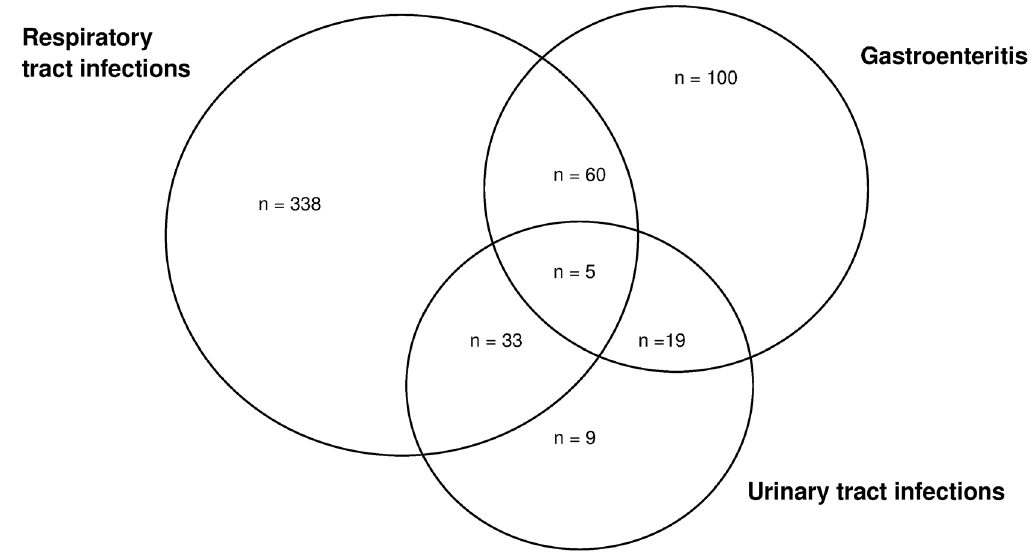
Figure 4. Co-infections of common diagnosis.